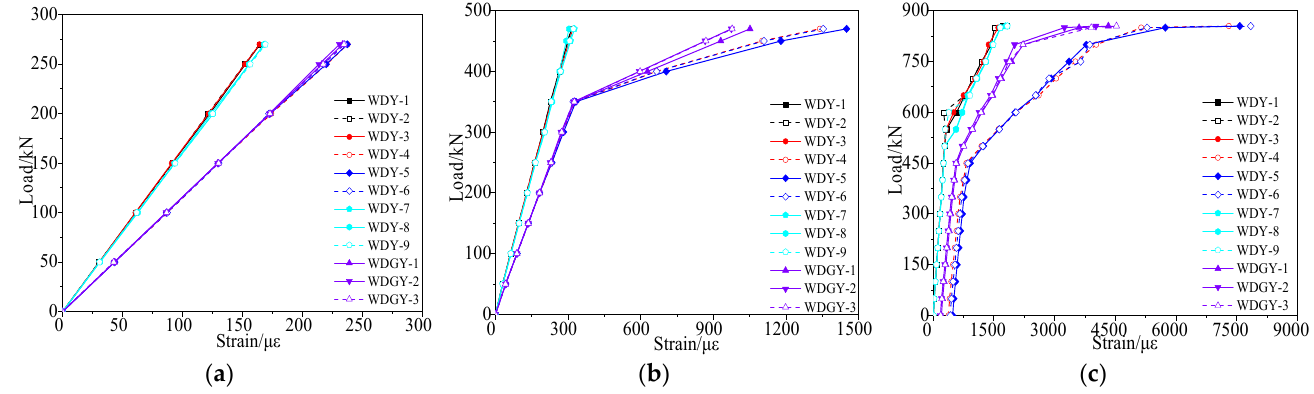
Figure 13. Strain vs. load curve of the undamaged test box girder bottom plate. ( a ) Elastic stage; ( b ) Working stage with cracks; ( c ) The failure stage.